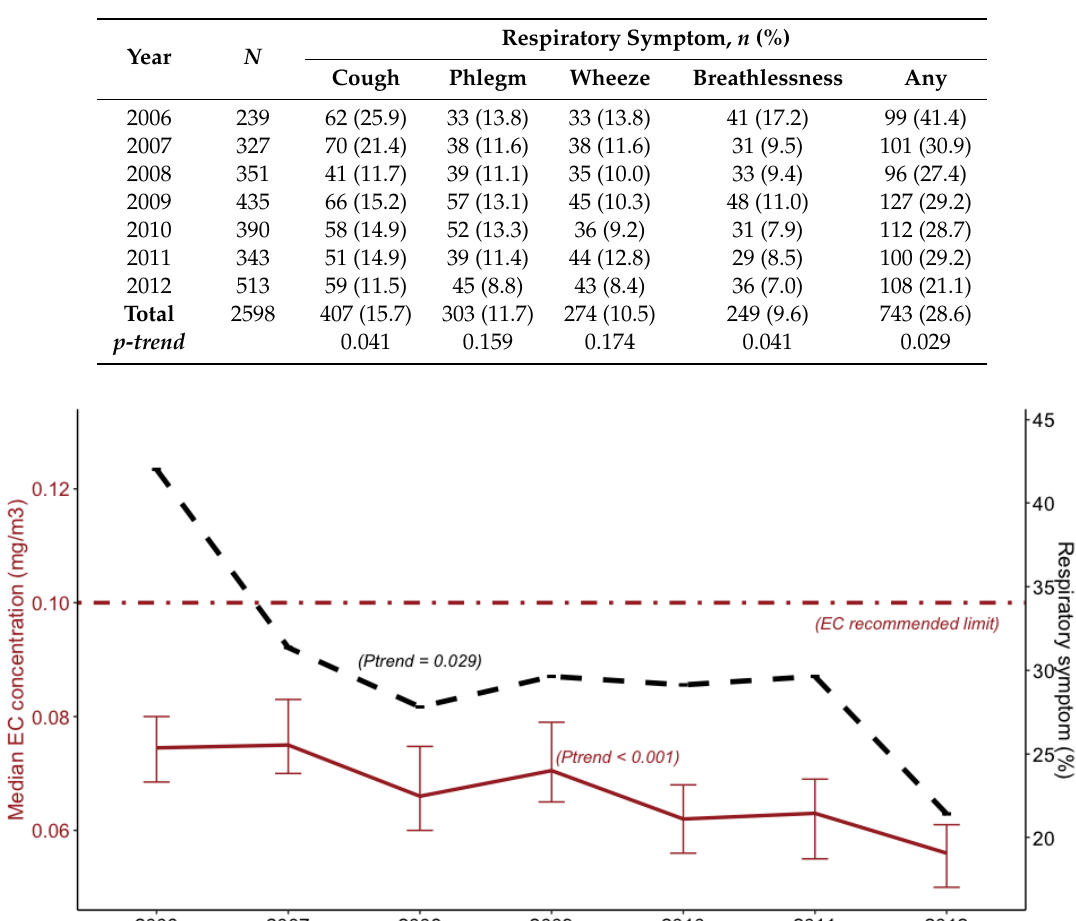
Table 3. Prevalence of respiratory symptoms of Western Australian miners, 2006–2012.